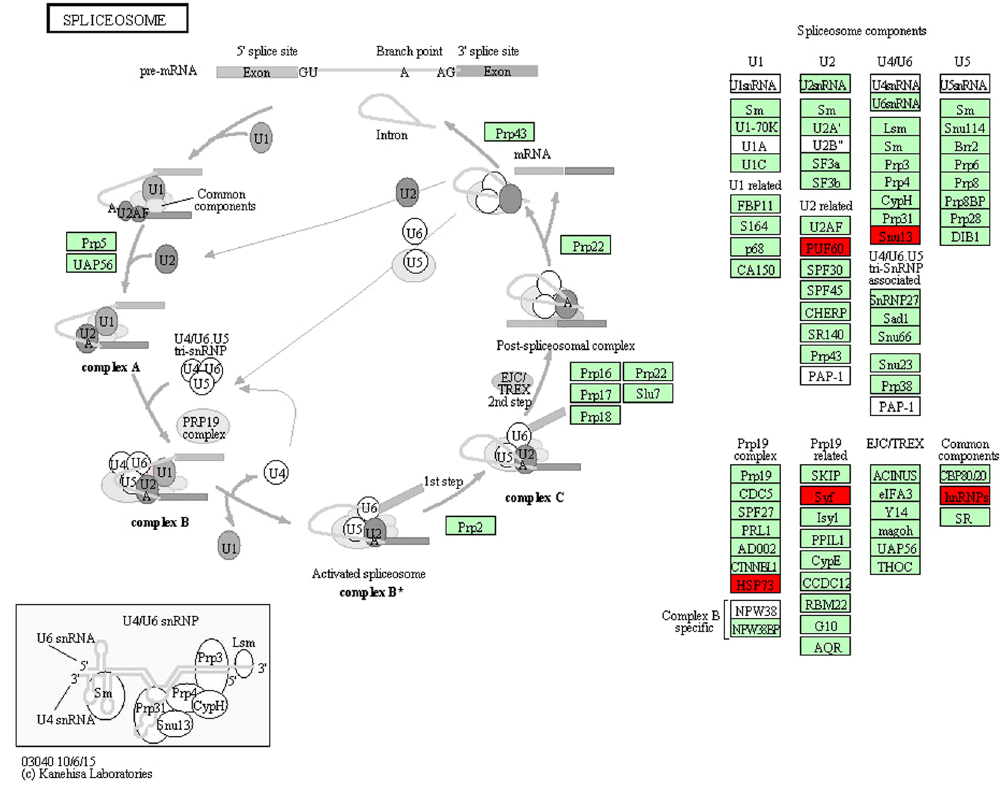
Figure 4. Cold-induced genes associated with the spliceosome pathway. 149 up-regulated DEGs were mapped to the KEGG pathway 36–38 using KOBAS. Up-regulated genes are displayed in